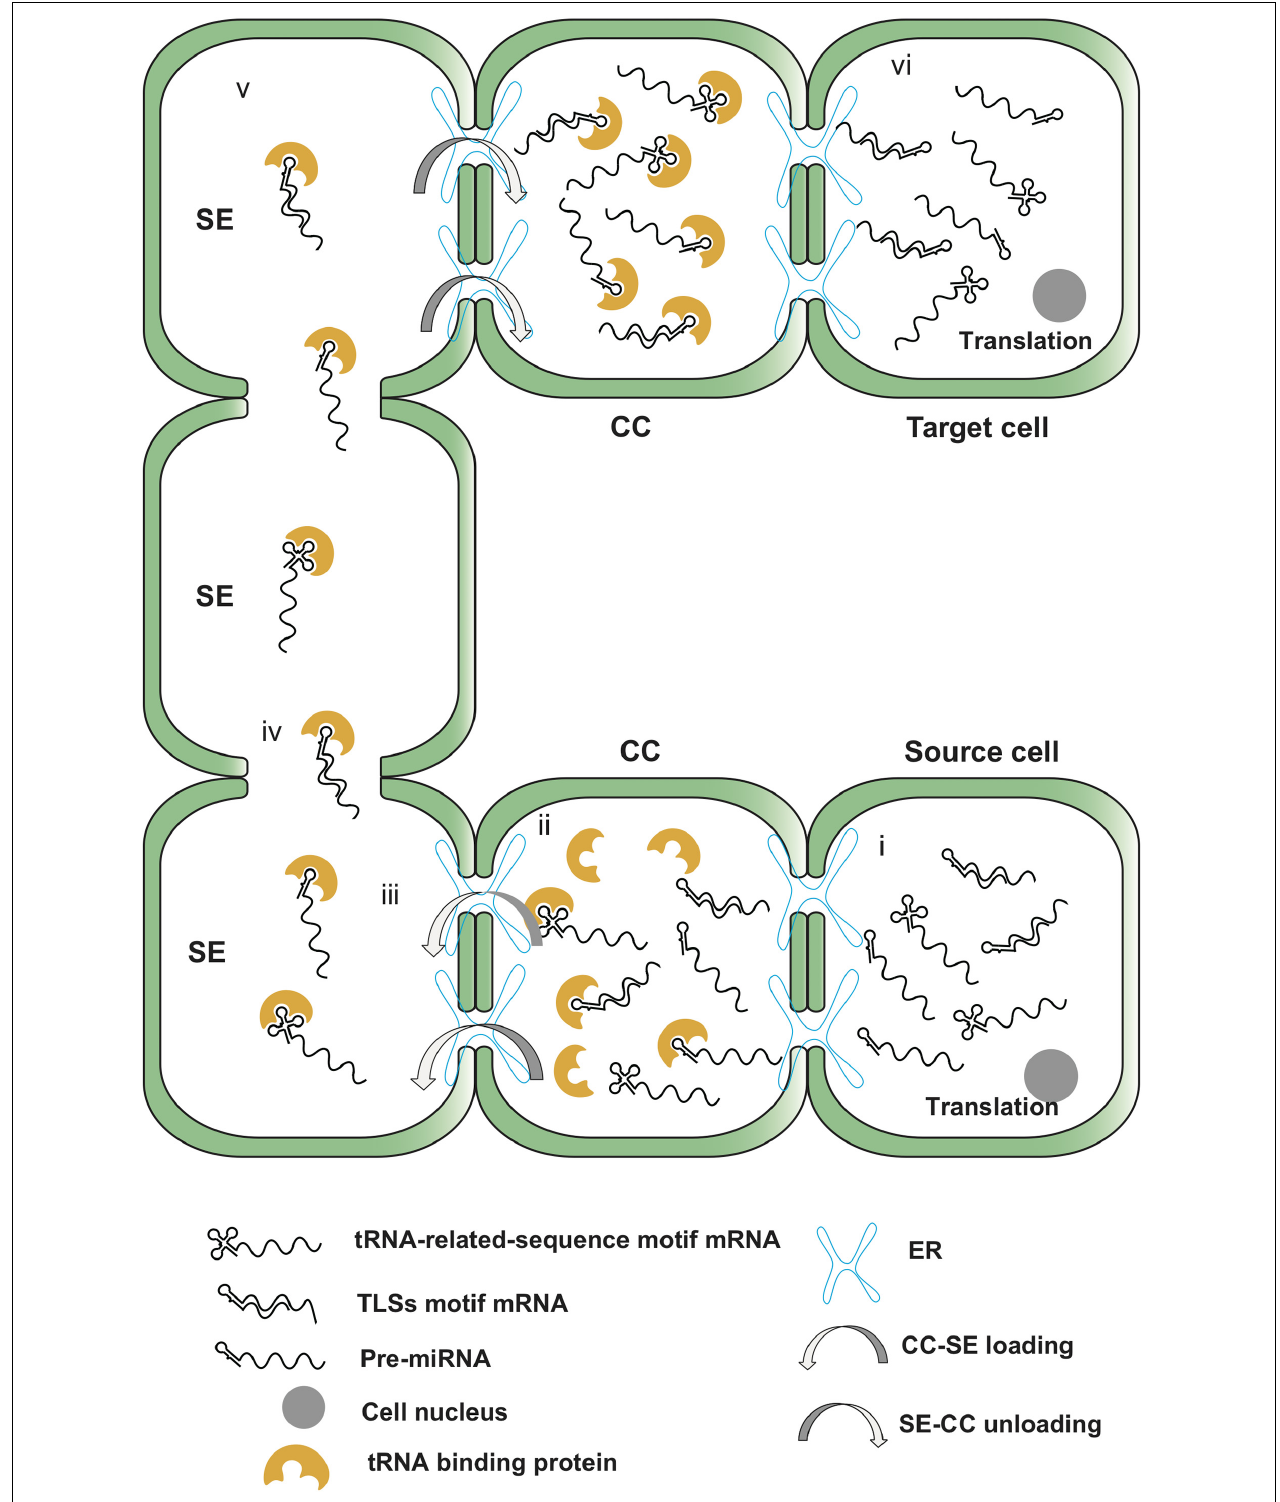
FIGURE 2 | The transportation pathway of mRNA triggered by TLSs and secondary hairpin structure of pre-miRNA. (i) Phloem-mobile mRNAs are transcribed in the source cell and transported from cell nucleus; (ii) The target phloem-mobile mRNA with secondary hairpin structure enters the CC and recognized by binding protein; (iii) The protein carries the target mRNA and pre-miRNA moves through the plasmodesmata assisted by PD receptor protein; (iv) mRNA and pre-miRNA molecules transport in SE; (v) mRNA and pre-miRNA unload from SE to CC; (vi) Finally, target RNAs enters the target cell and translate to functional proteins.